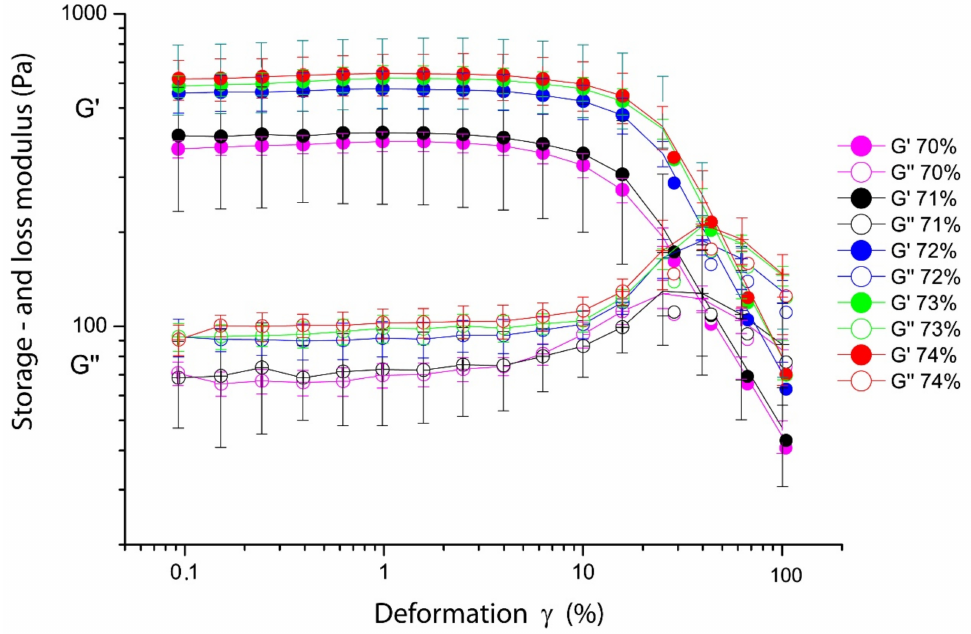
Figure 10. The storage ( G ’) and loss ( G’ ’) modulus in amplitude sweeps of fresh milk emulsions from concentrations 70 to